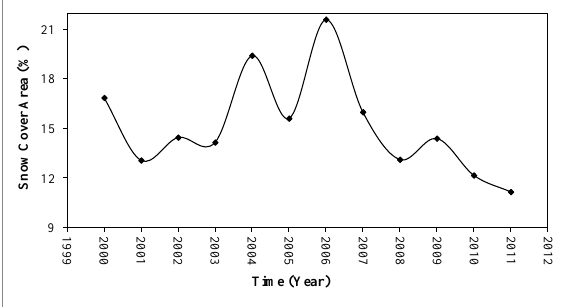
Figure 3. Inter annual variation in SCA, 2000-2011